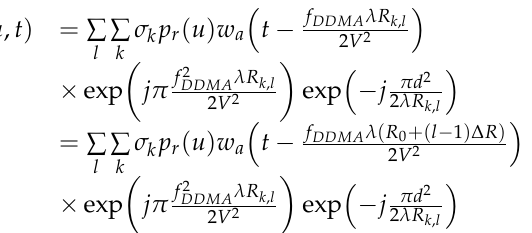
ambiguous regions caused by the proposed method, the aliasing is brought among differ- ent ambiguous regions in Figure 5. So, the applicable conditions of the proposed method are explored further in this paper.